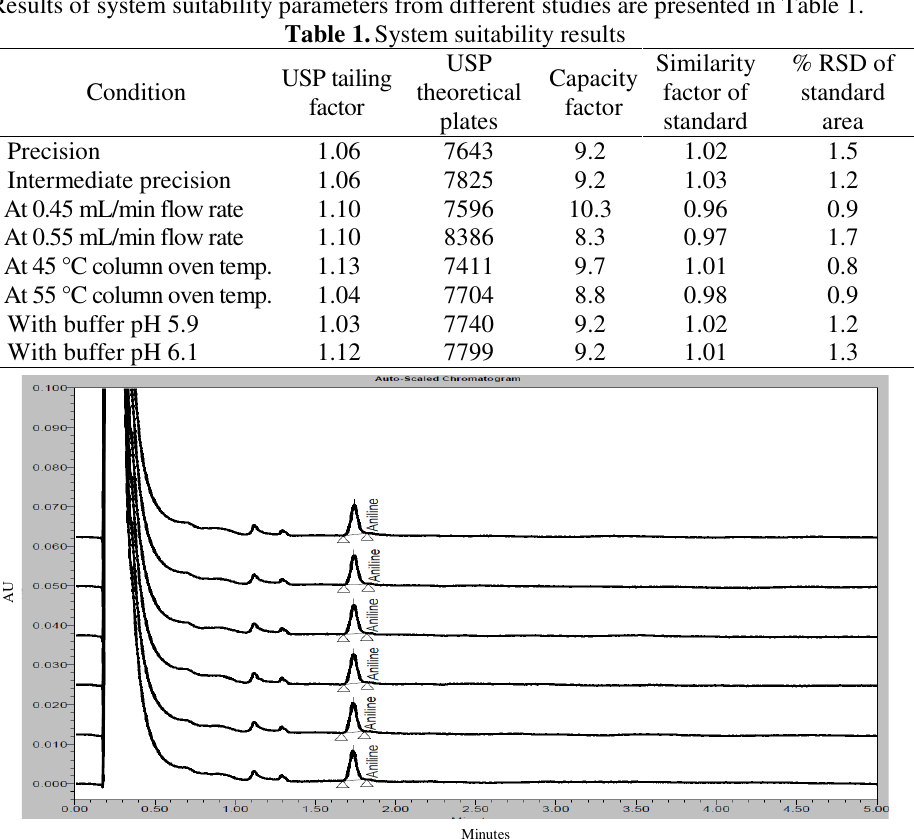
Figure 2. Overlay chromatograms of replicate standard